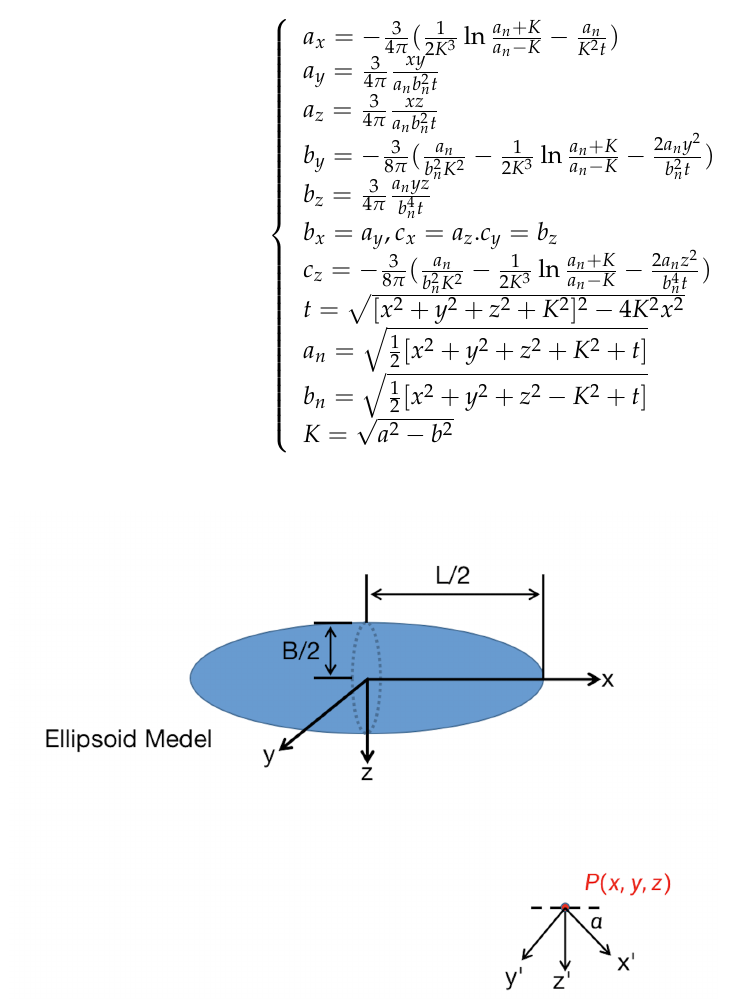
Figure 1. Schematics of the uniformly Magnetized spheroid model of the vehicle. Place the sensor at the measuring point P and the coordinate system of the measuring point is also shown in Figure 1, where the z ’ axis is vertically downward while the angle between the x ’ axis and the target heading, i.e., the x -axis, is α . Assuming that the target moves in a straight line at a uniform speed along the x -direction, while the speed is v , and the sampling interval is D T . Supposed that the speed of the target does not change when the target passes for a short time. Then, the relationship between the j’s output of the sensor (i.e., the target’s radiated magnetic fields) is: